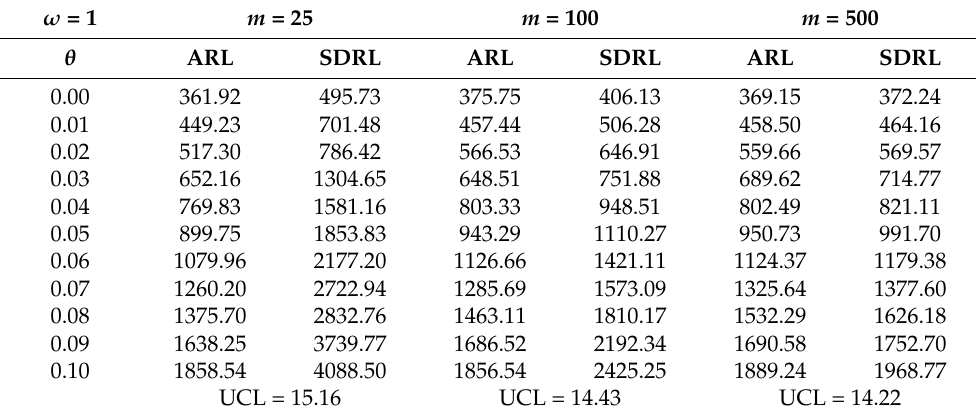
Table 5. ARL 0 and SDRL 0 values of the proposed SDRE multivariate Shewhart control chart ( ω = 1). ω = 1 m = 25